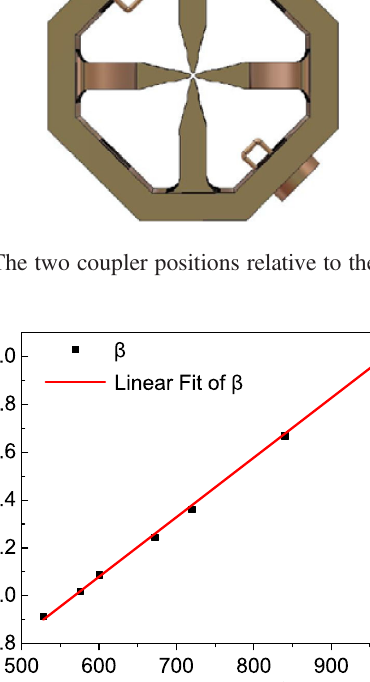
FIG. 30. The reflected power as a function of the input beam current with the optimum coupling factor of 2. The resonant frequency has been detuned to the optimal value for different values of the beam current.